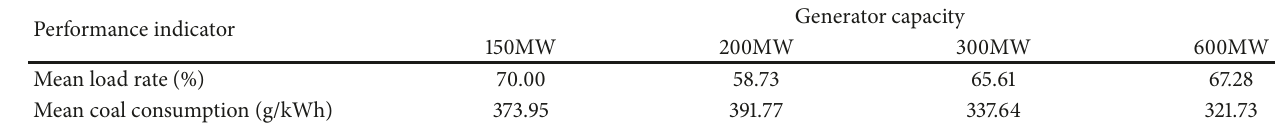
Table 12: Operation performance of various capacity generators.